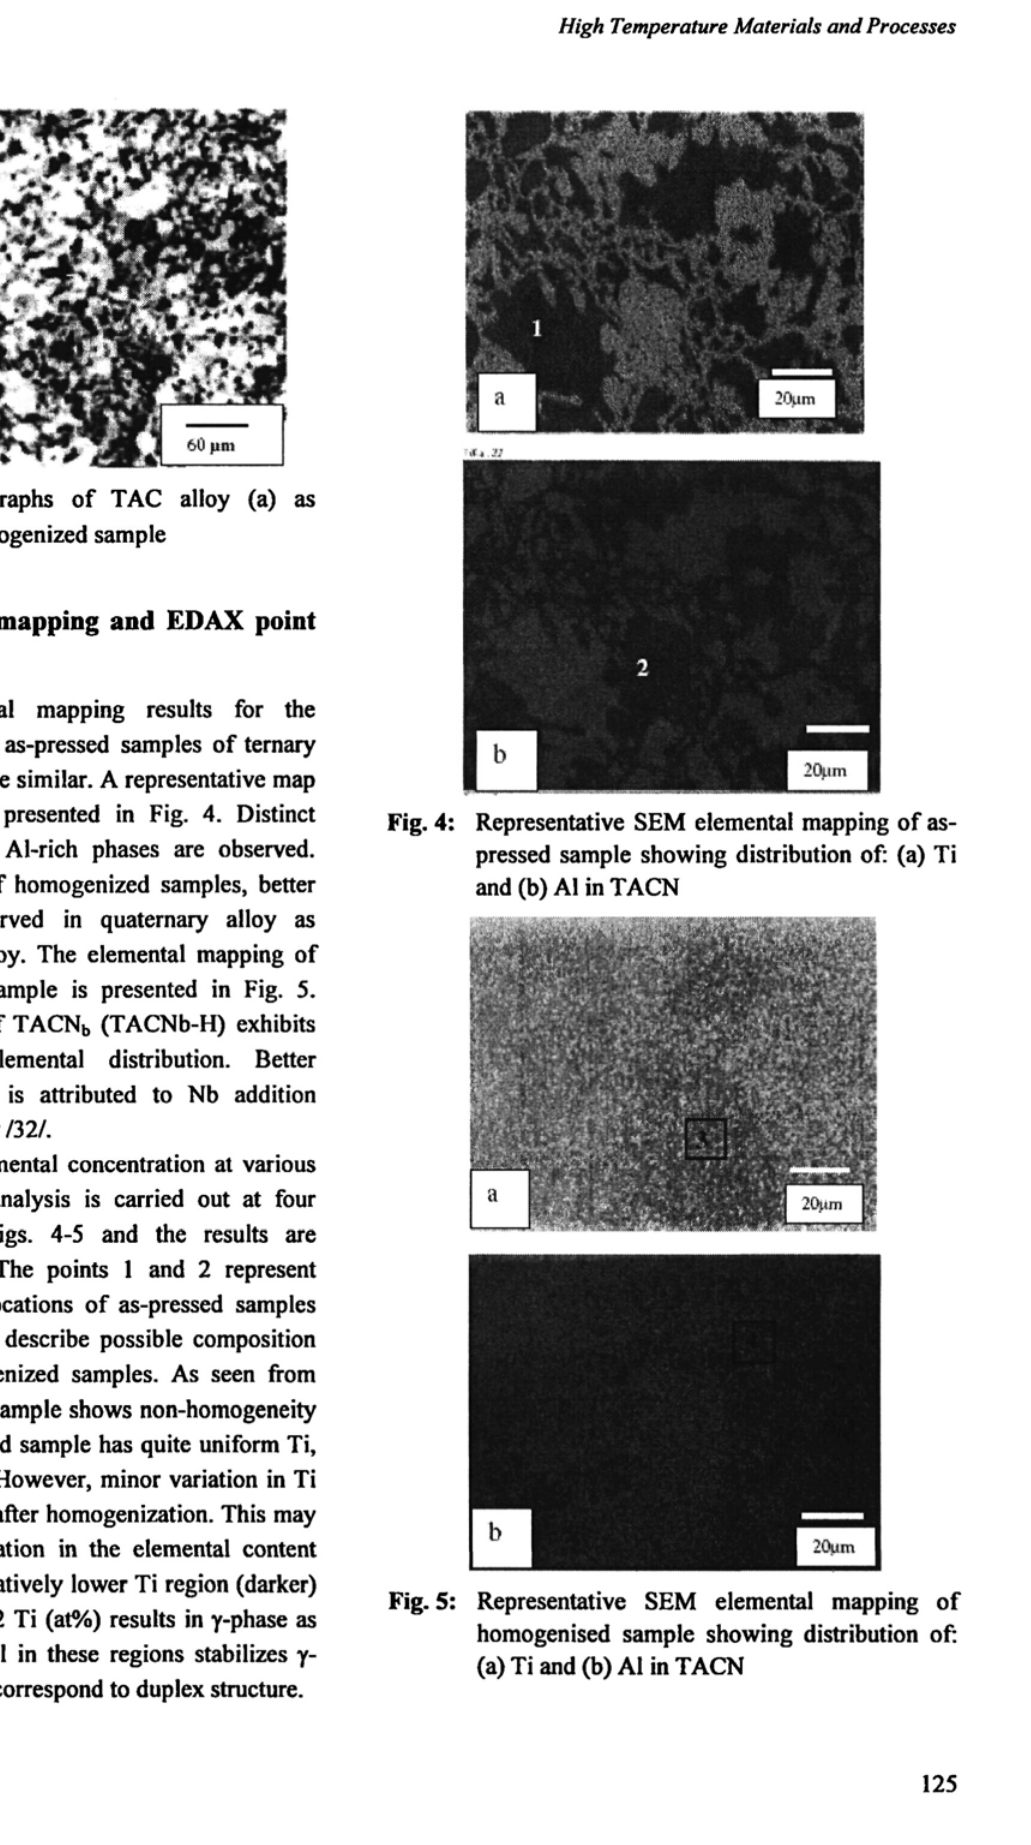
Fig. 5: Representative SEM elemental mapping of homogenised sample showing distribution of: